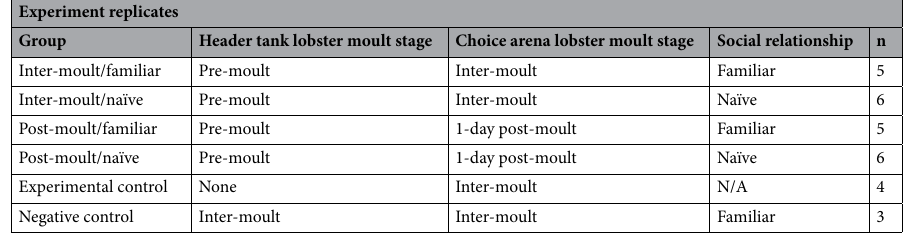
Experiment replicates Group Header tank lobster moult stage Choice arena lobster moult stage Social relationship n Inter-moult/familiar Inter-moult/naïve